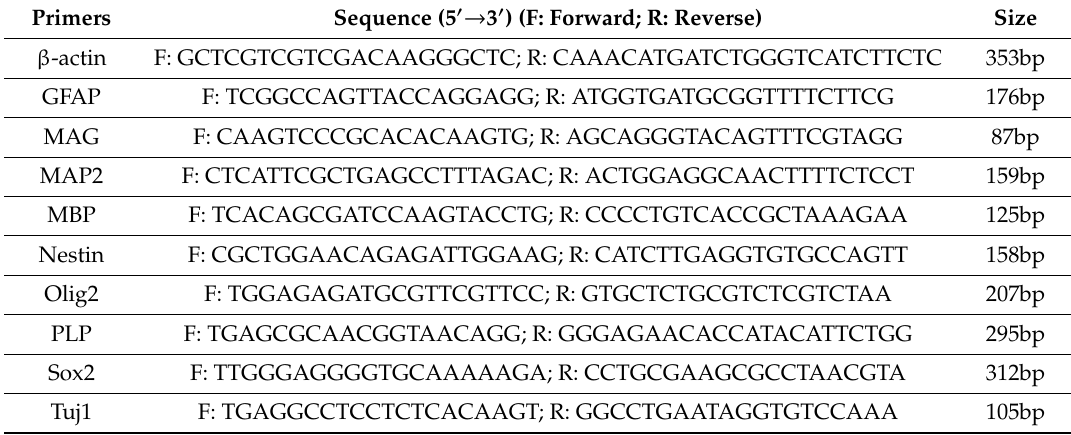
Table 1. List and sequence of mouse primers used for RT-PCR